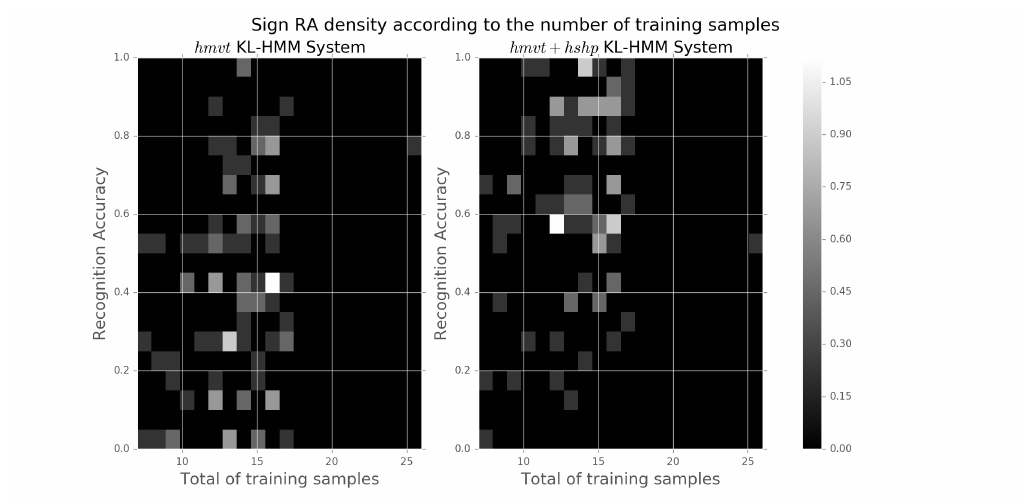
Figure 10. Sign RA density according to the number of training samples according to the KL-HMM system using the TSL movement subunit ( hmvt ) or using both with the hand shape information ( hmvt+hshp